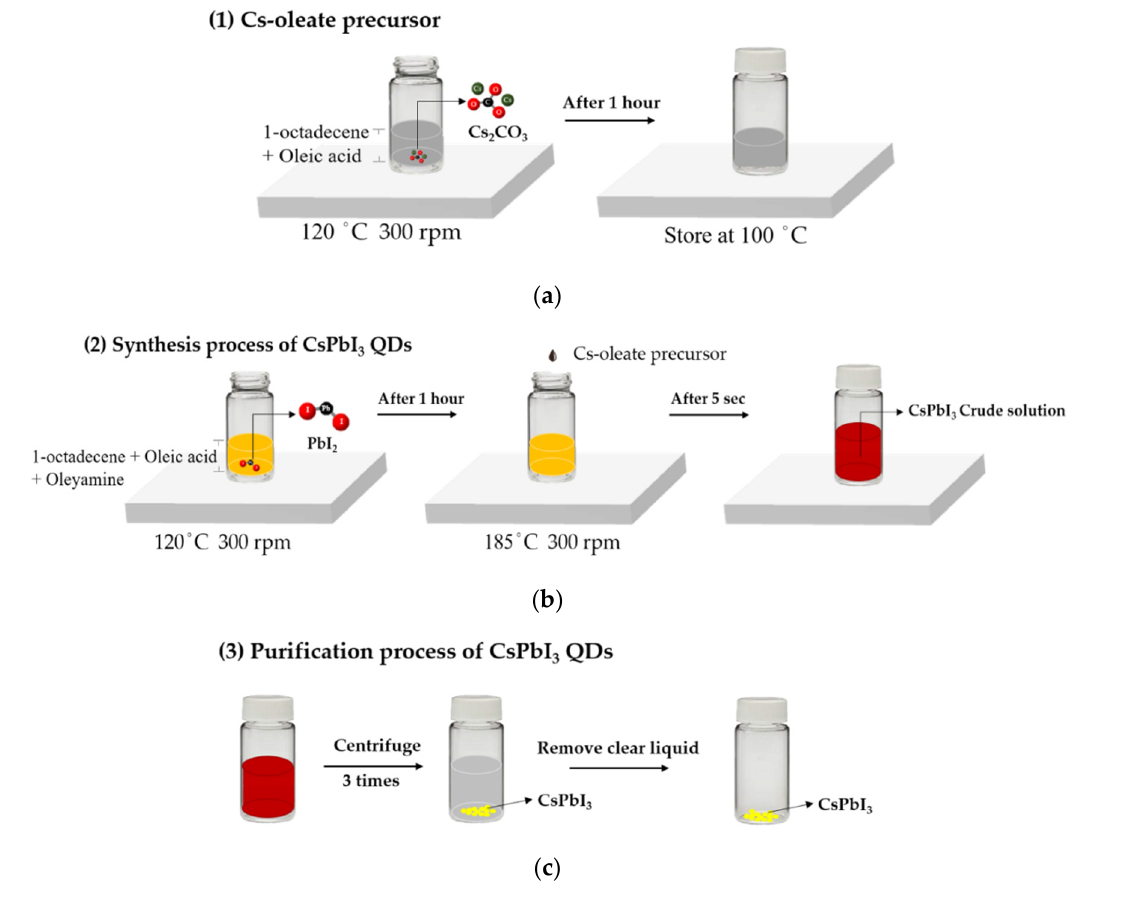
Figure 1. ( a – c ). Schematic diagram of perovskite quantum dots and fabrication of thin film.